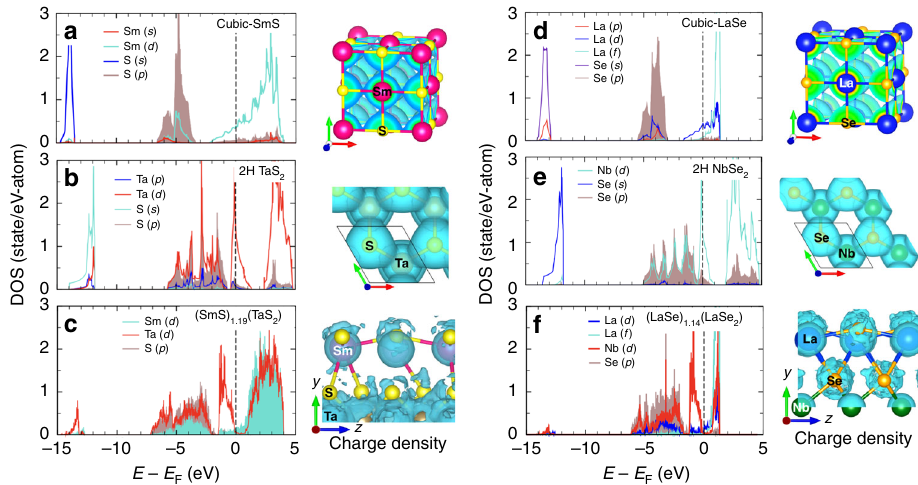
Fig. 7 DOS calculations for (REX) n (MX 2 ) heterostructures. a Partial DOS and charge density of cubic-SmS, b 2H-TaS 2 , c (SmS) 1.19 (TaS 2 ), d cubic-LaSe, e 2H-NbSe 2 , and f (LaSe) 1.14 (NbSe 2 ). Charge density isosurfaces (0.03 e − /Å 3 ) are plotted to highlight